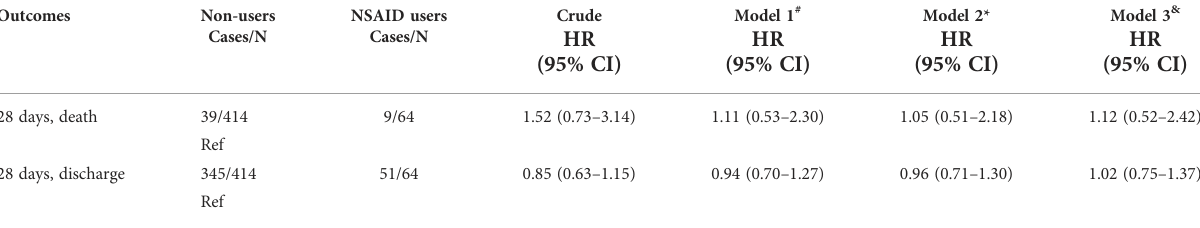
TABLE 2 Association between use of NSAIDs, 28-day mortality, and hospital discharge in patients with COVID-19.